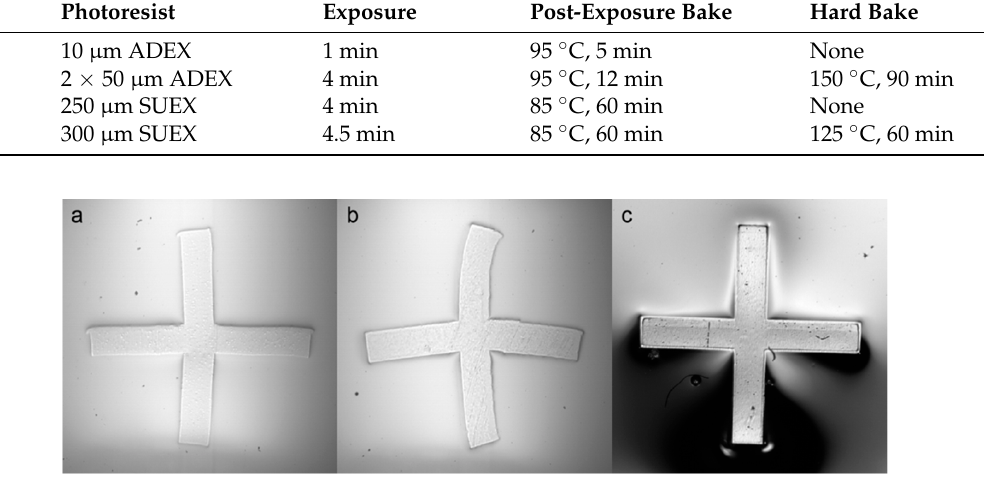
Figure 1. Results of post-exposure bake trials to study SUEX distortion: ( a ) Trial 1, ( b ) Trial 2, and ( c ) Trial 3. Distortion is minimized in Trial 3 by slow changes in temperature.